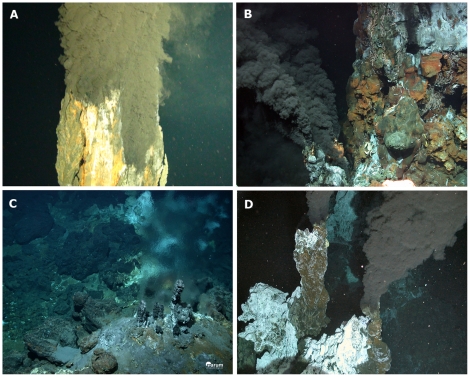
Photos showing some of the newly discovered deep-water chemosynthetic habitats found during ChEss.A) The Beebe Vent, Piccard Hydrothermal Field on the Mid-Cayman Rise (4960 m depth), image taken by HyBIS during Voyage 44 of the RRS James Cook, April 2010 (© Jon Copley, University of Southampton/NOCS) (Connelly et al,. 2011); B, Turtle Pits hydrothermal vent, first vents discovered on the South MAR, 2005 (© ROV Quest, Marum, Bremen); C, Bubbylon hydrothermal vents on the North MAR discovered near the Azores in October 2010 (© ROV Quest, Marum, Bremen); D, Black smokers on the East Scotia Ridge south of the Polar Front discovered in January 2009 (©Paul Tyler and Jon Copley, ChEsSo Consortium, University of Southampton, UK, ROV Isis).